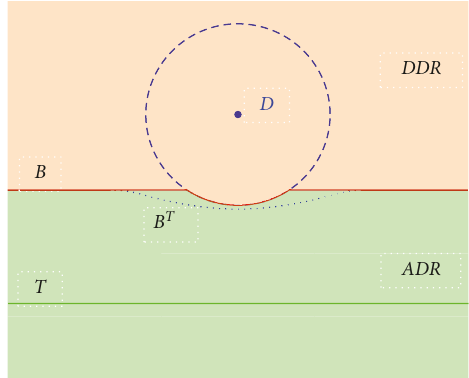
Figure 8: The barrier of the game with y